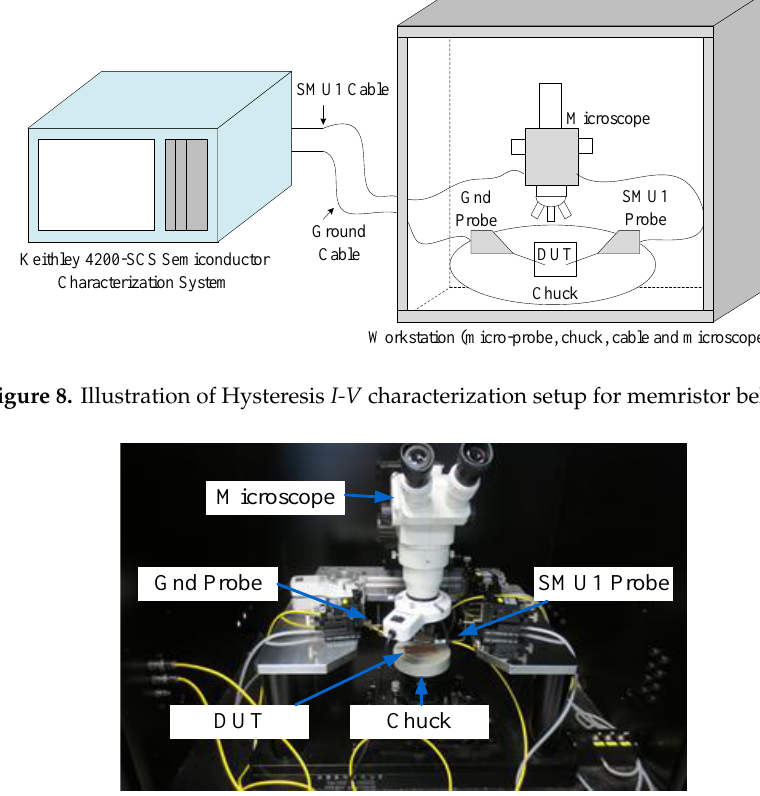
Figure 9. Photograph image of Hysteresis I-V characterization setup for memristor behavior.